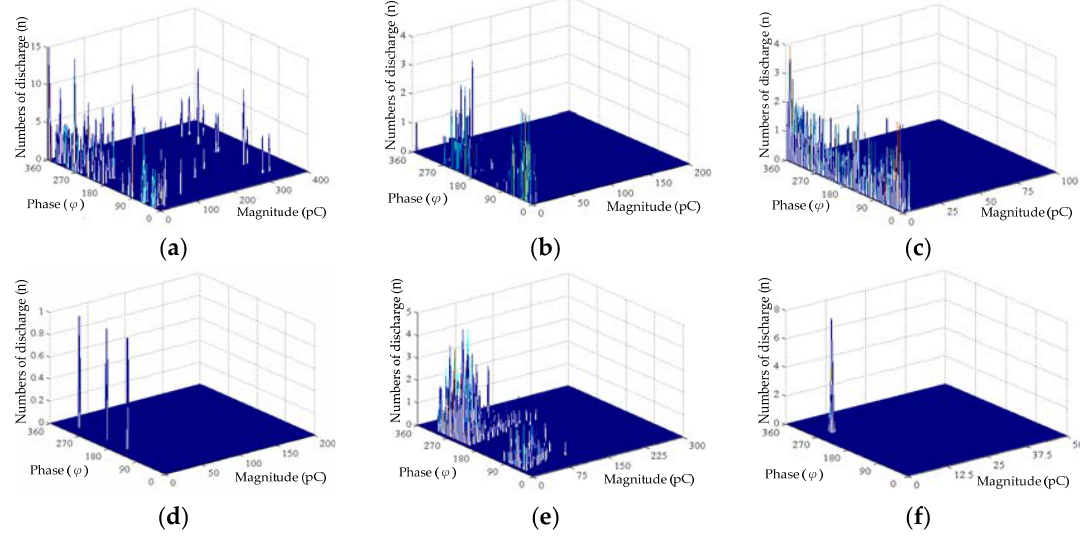
Figure 15. Phase-resolved 3D patterns for ( a ) Type I ( b ) Type II ( c ) Type III ( d ) Type IV ( e ) Type V and ( f ) Type VI.